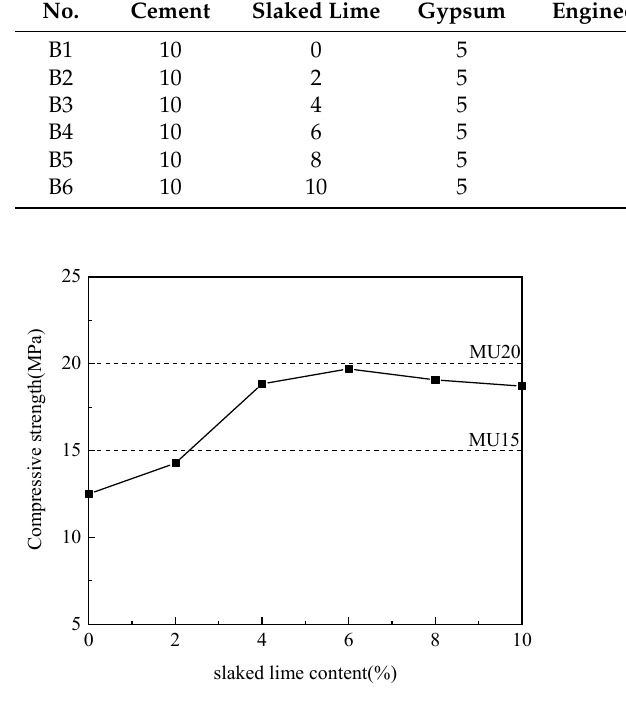
Figure 5. Effect of slaked lime content on compressive